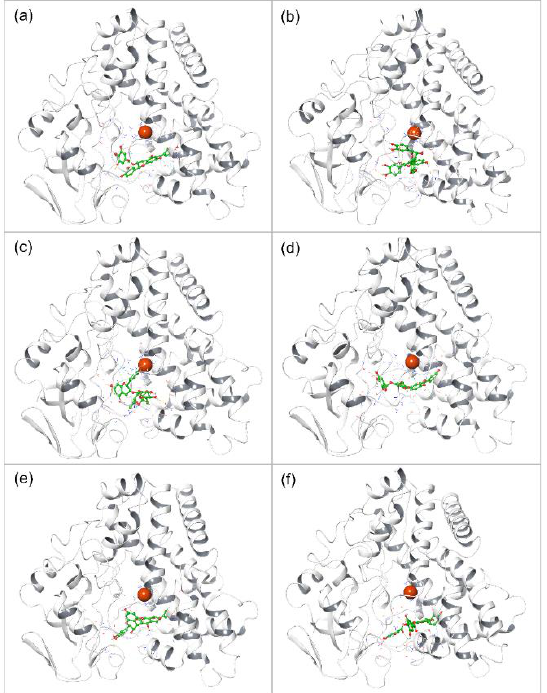
Figure 1. Three-dimensional interaction illustration of protein binding with ligands ( a ) Catechin 3,7,-Di- O -Galate, ( b ) Catechin 5,7,-Di- O -Gallatec, ( c ) Catechin 5,4 ’ -Di- O -Gallate, ( d ) Epifisetinidol-(4beta->8)-Catechin, ( e ) Catechin 3- O -Rutinoside, ( f ) Epicatechin (4b->6) Catechin. (Light Gray->Protein, Green->Ligand, Red ball/blue residue->Heme co-factor).